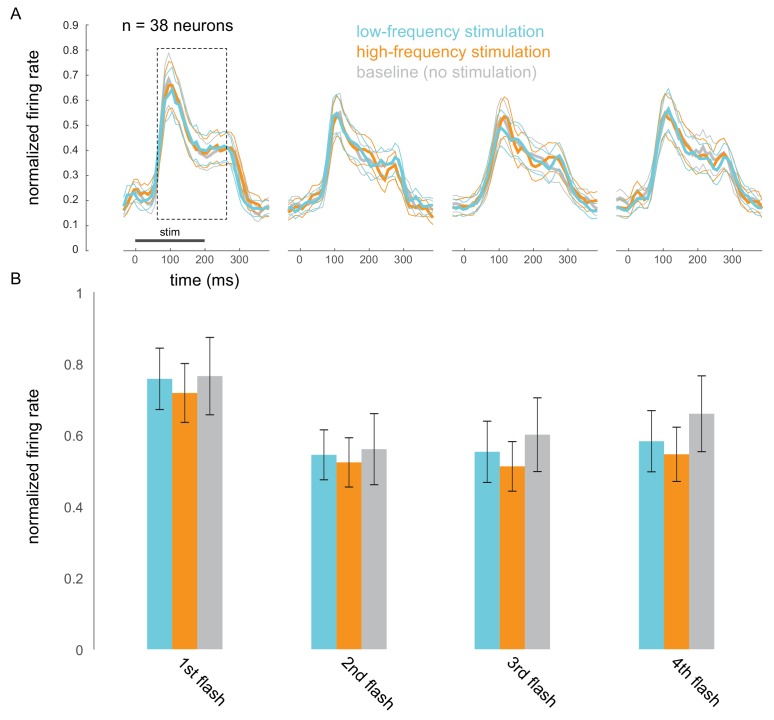
Optical stimulation does not cause frequency-specific adaptation.(A) Responses evoked by the first four non-target stimuli, for trials in which attention was cued to the stimuli appearing at the opsin site. Responses were averaged and normalized for each neuron to the maximum response across all stimulus positions. Normalized responses were then averaged across 38 neurons recorded in 15 sessions. (B) The corresponding average firing rates over the 200 ms stimulus-evoked period indicated by the box in A (60–260 ms post stimulus onset).